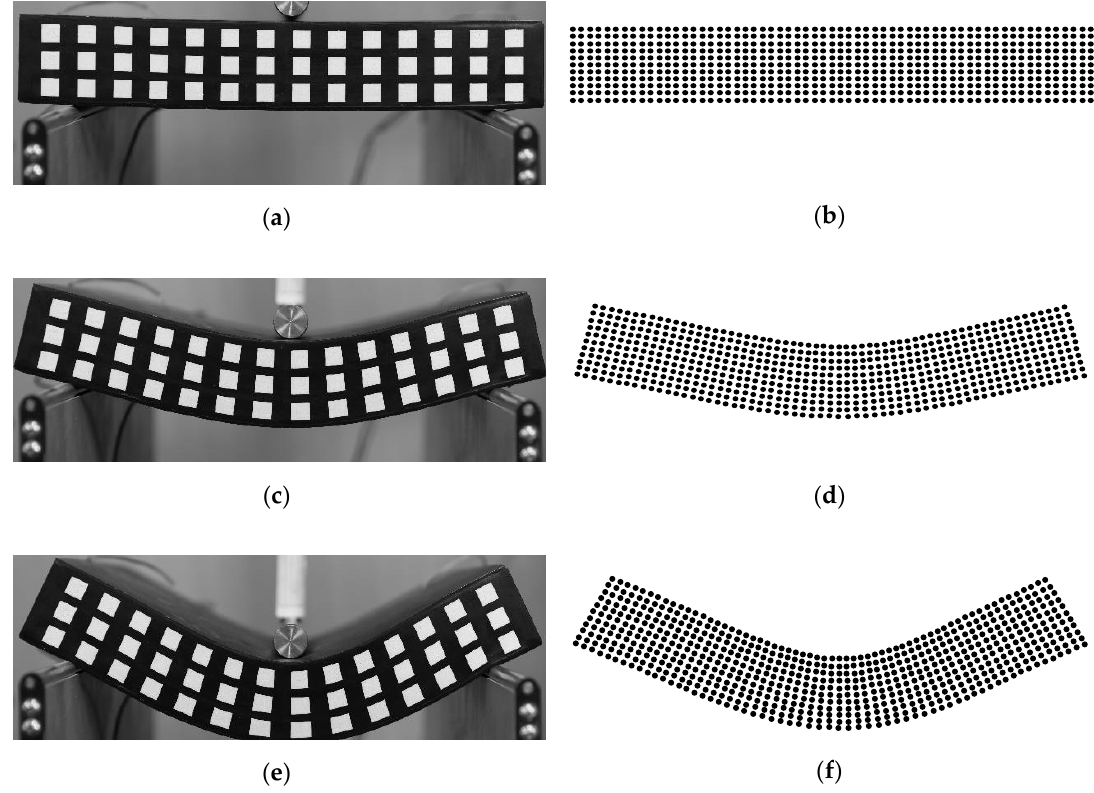
Figure 13. Comparison of the mechanical test and numerical analysis. ( a ) Trimmed image at t = 0 s, ( b ) PDM model at t = 0 s. ( c ) Trimmed image at t = 220 s. ( d ) PDM model at t = 220 s. ( e ) Trimmed image at t = 460 s. ( f ) PDM model at t = 460 s.